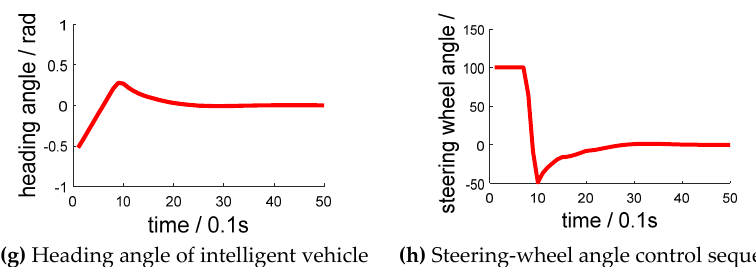
Figure 8. Lane retention experiment.